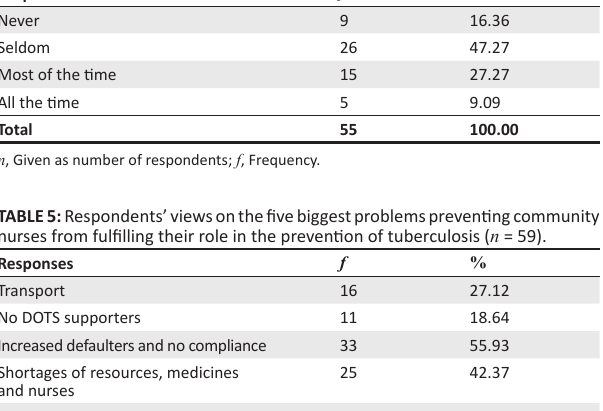
TABLE 4: Respondents’ views on how often they get involved in research ( n = 55). Responses